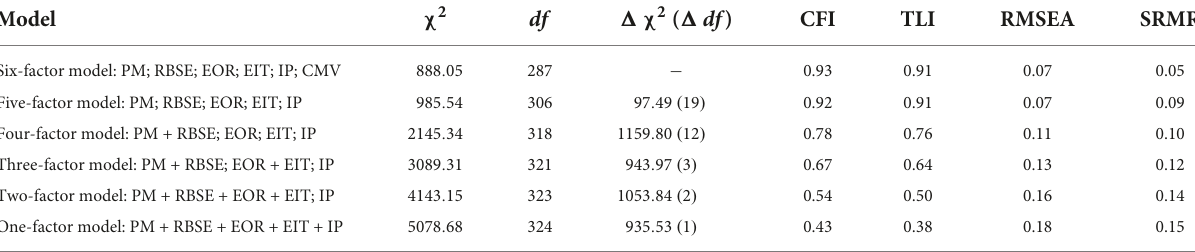
TABLE 2 Results of the confirmatory factor analysis for the study variables.